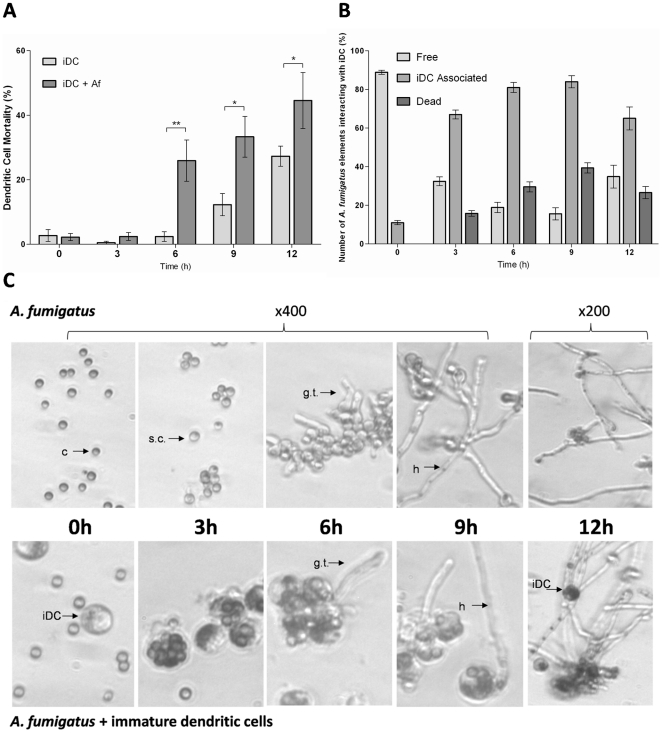
Interaction of iDC and A. fumigatus in vitro.Cell death of (a) immature Dendritic cells (iDC) asterisks indicate where there was a significant difference between treatments at each time point (t-test, p<0.05), and (b) A. fumigatus during their interaction over 12 h in RPMI medium incubated at 37°C and 5% CO2. iDC associated A. fumigatus included conidia that were ingested and those in direct physical contact with iDC. Both iDC and A. fumigatus were stained with neutral red for monitoring of viability by light microscopy. The viability of each was determined from the total number of cells / fungal elements observed at that time point. There were three replicate experiments and 300 cells over 10 fields of view were counted per time point, charts show the mean and standard errors. (c) Light micrographs of A. fumigatus developing from resting conidia to hyphae over 12 h in the presence or absence of iDCs; c – conidia, s.c. – swollen conidia, g.t. – germ tubes, h – hyphae, iDC – immature dendritic cells.